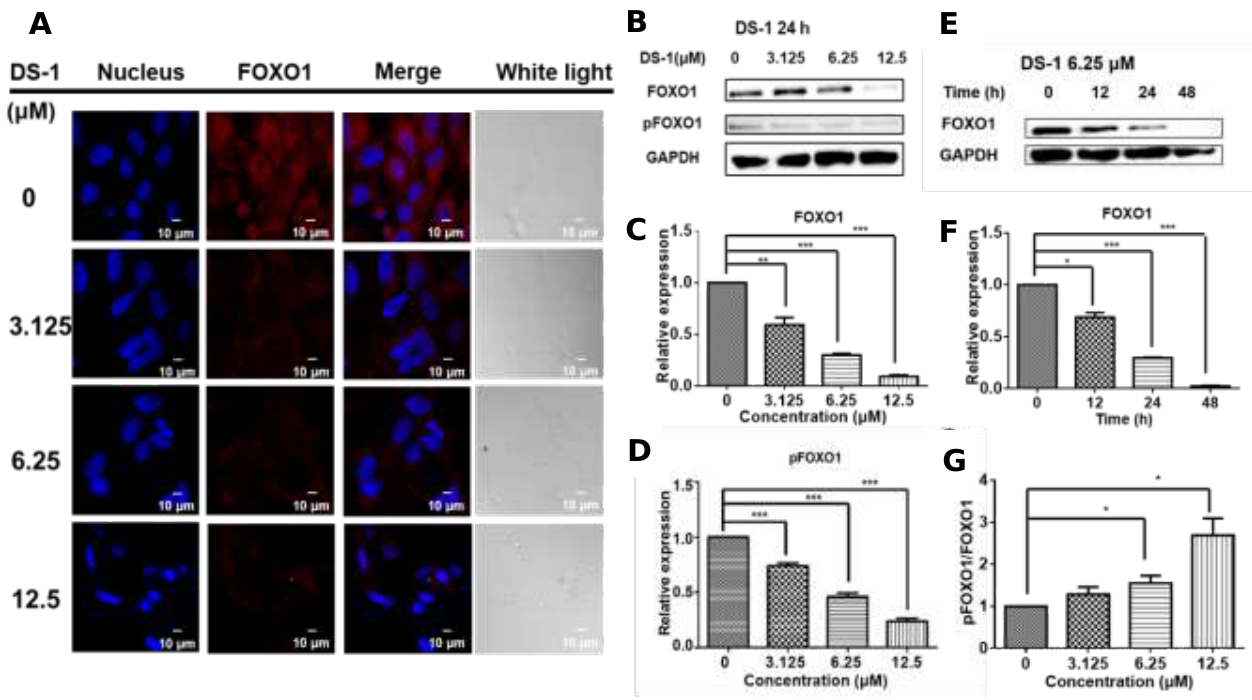
Figure 3. DS − 1 inhibited the expression of transcription factor FOXO1 in U − 2 OS cells. ( A ) U − 2 OS cells were treated with DS − 1 at 0, 3.125, 6.25, and 12.5 µ M, and the changes in FOXO1 were analyzed by immunofluorescent staining, followed by confocal microscopy imaging. ( B ) U − 2OS cells were treated with DS − 1 at 0, 3.125, 6.25, and 12.5 µ M, and FOXO1 and pFOXO1 were analyzed by Western blot; the changes were presented in histograms ( C , D ). ( E ) U − 2 OS cells were treated with DS − 1 at 6.25 µ M for 0, 12, 24, and 48 h, then FOXO1 was analyzed by Western blot, and the changes are presented in the histogram ( F ). ( G ) The pFOXO1/FOXO1 value is shown in the histogram. Values are the average of three independent experiments, * p < 0.05, ** p < 0.01, *** p < 0.005.